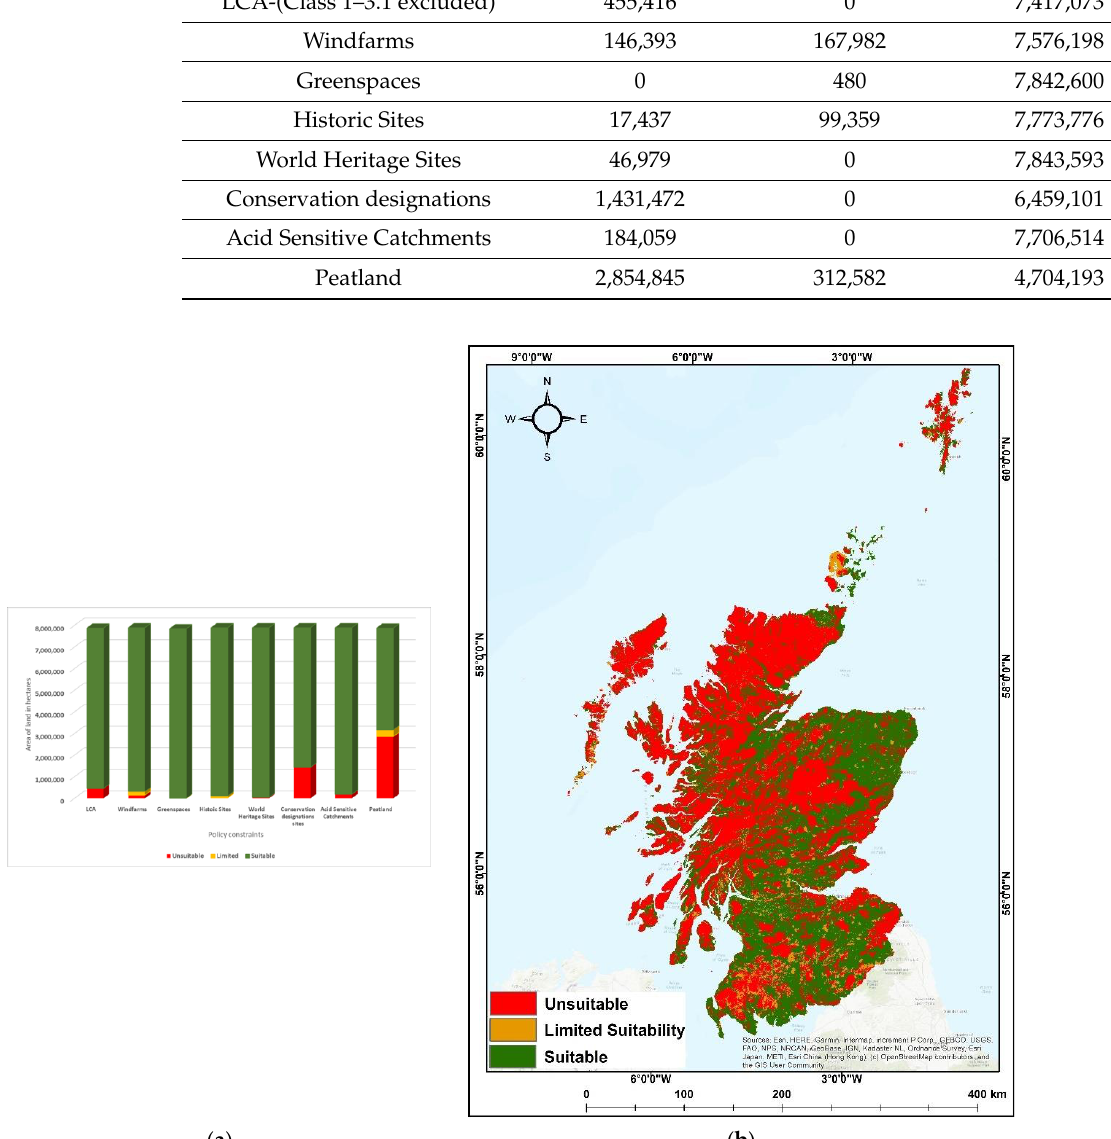
Figure 5. ( a ) Unsuitable/limited/suitable areas restricted by current policy constraints in